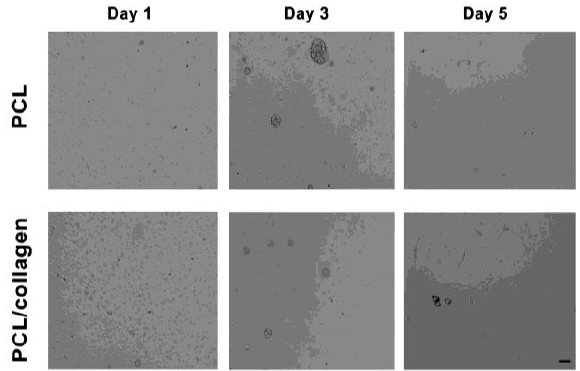
Figure 5. Neurospheres adhered and proliferated on electrospun PCL or PCL/collagen nanofibers after 1, 3, and 5 days. Scale bar = 100 μm.